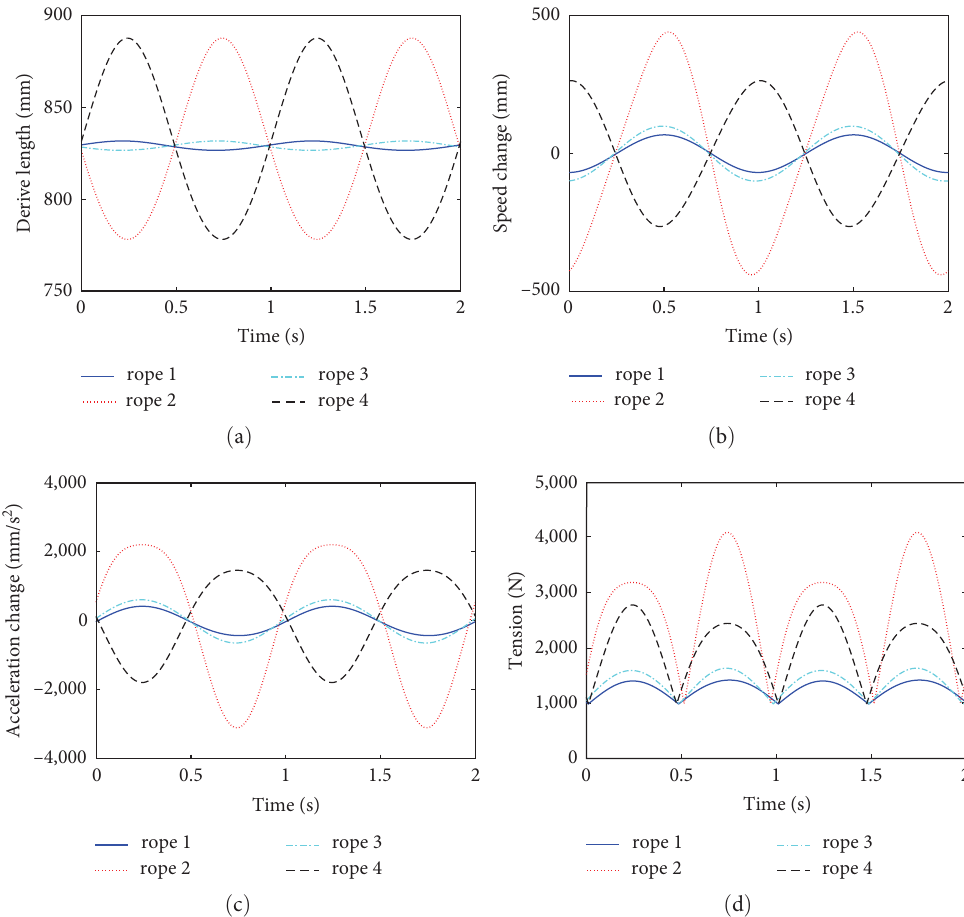
F IGURE 10: Dynamic simulation analysis of antiswing device for hanging